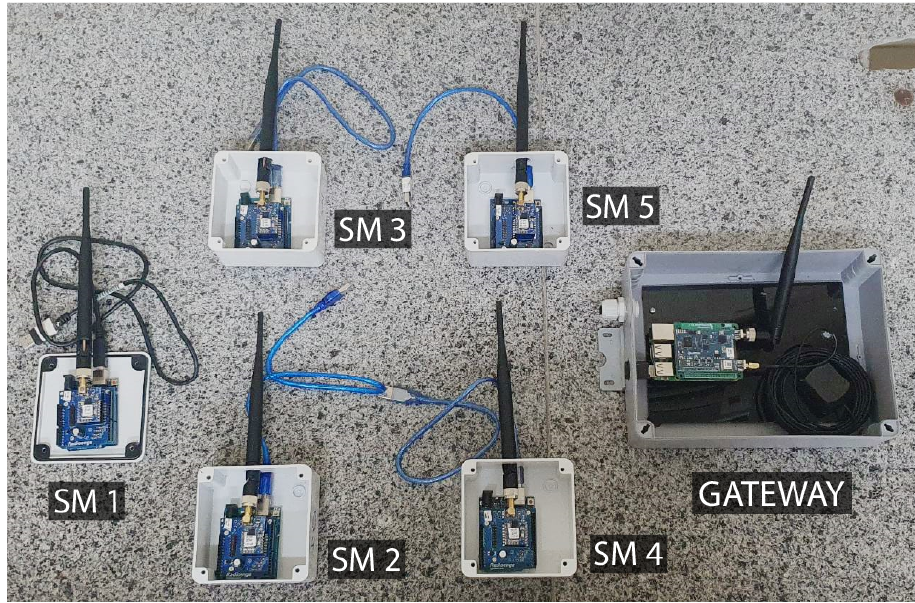
Figure 14. Components used for LoRaWAN